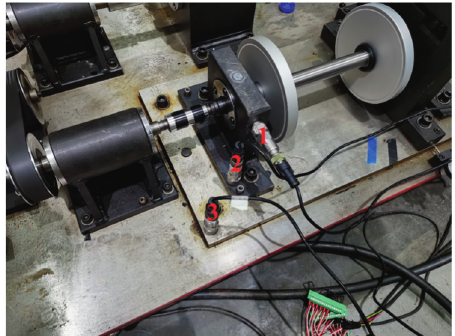
Figure 11: Sensor installation position for misalignment fault simulation